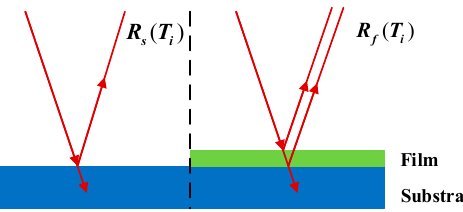
Figure 1. The schematic diagram of in-situ DRS model in the variable temperature environment.